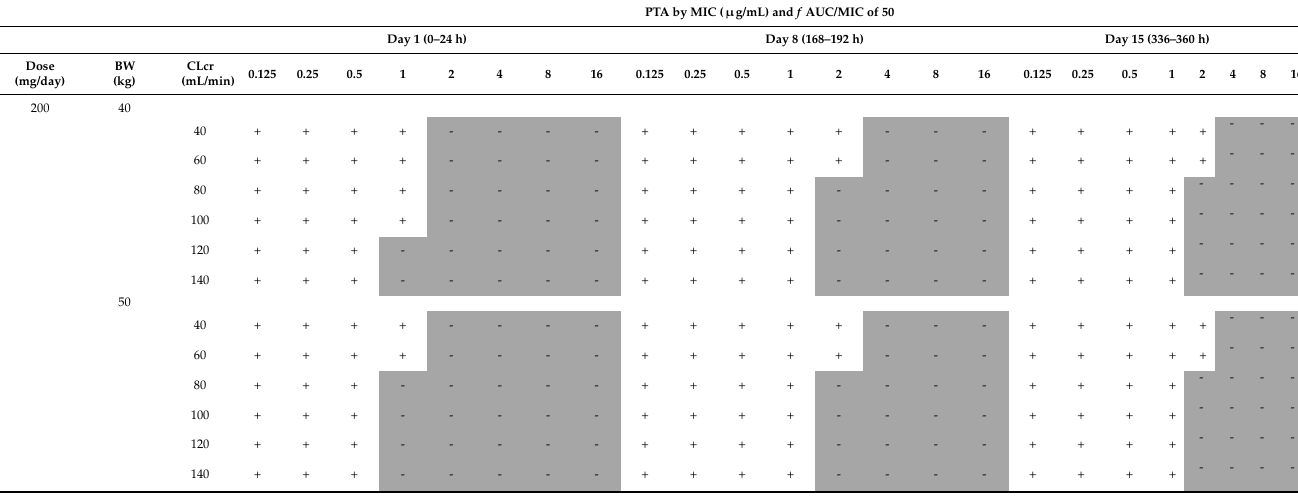
Table 3. Fluconazole probability of target attainment (PTA) at different BW, CLcr, and loading dose regimen on Day 1, 8, and